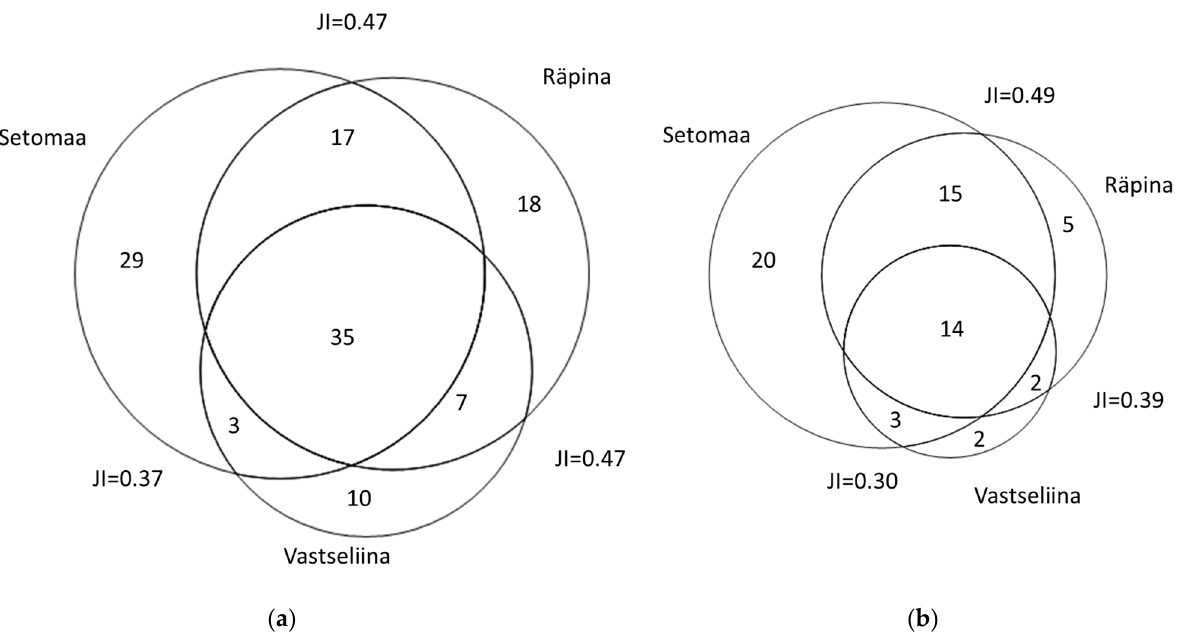
Figure 3. A comparison of ( a ) all plants and ( b ) those used in three or more UR in the three studied parishes. JI—Jaccard Index.